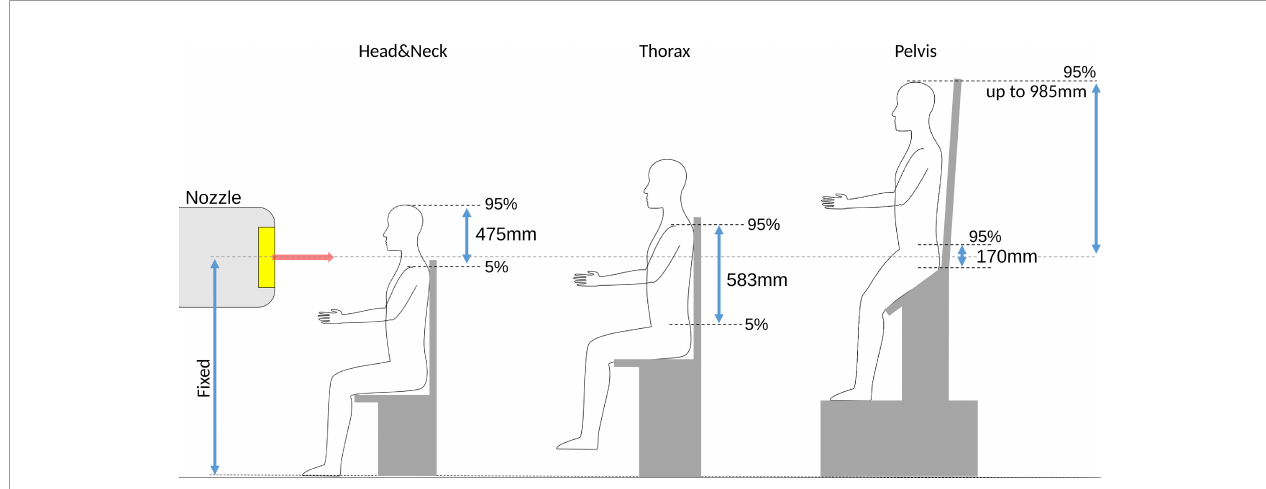
FIGURE 2 | Overview over the required vertical ranges (not to scale) of adjustment for different treatment sites for European adults, computed as the difference between 5 and 95 percentiles from anthropomorphic data in (49). An important constraint for an upright positioning device targeted for a fi xed beam line is the fi xed height of the isocenter. For pelvis treatments, the patient head can reach up to ~1m above the